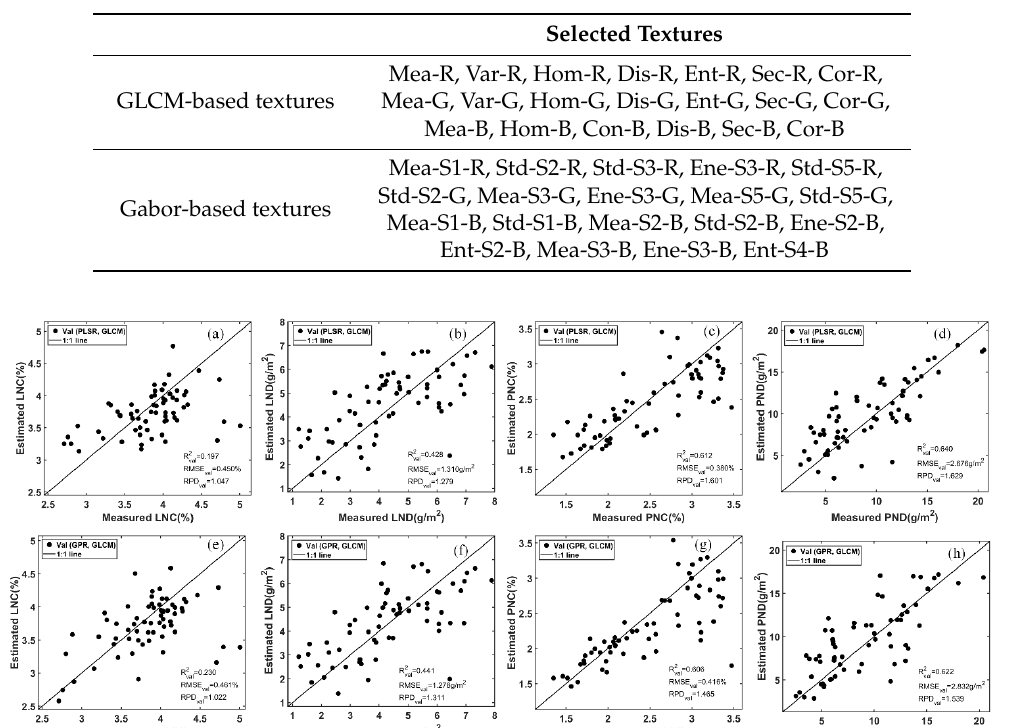
Table 4. The GLCM- and Gabor-based textures left after removing highly correlated features.